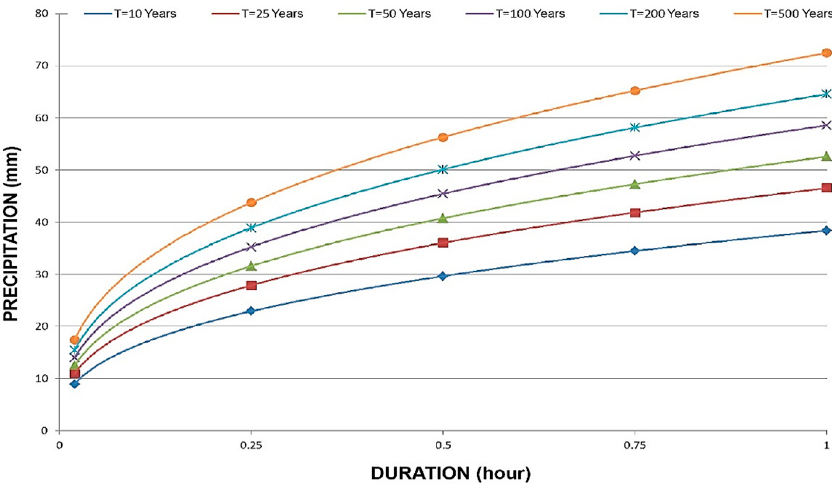
Figure 2. Depth–duration–frequency curves for Parma University station (duration up to 1 h).